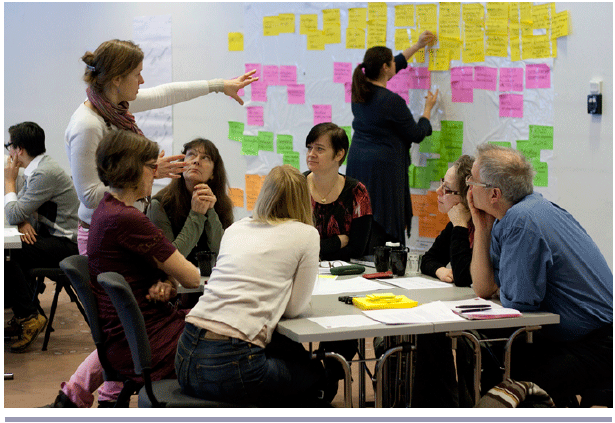
Fig. 4 . The resilience assessment workshop in